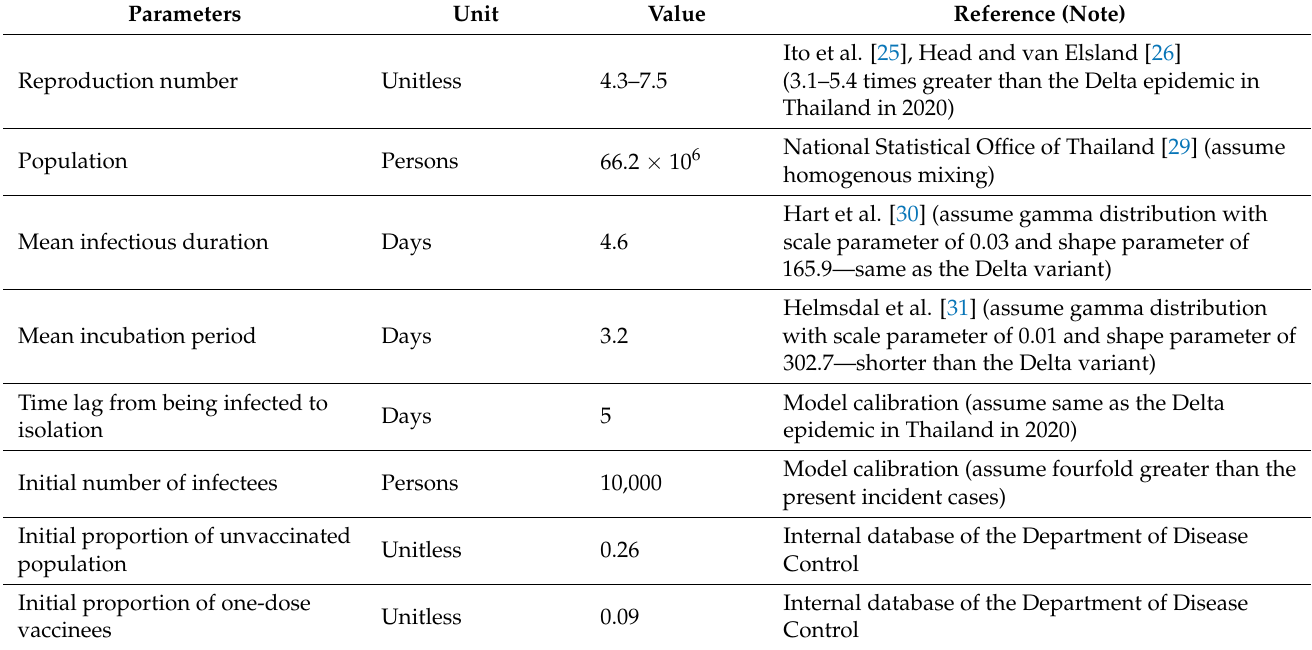
Table 1. List of essential